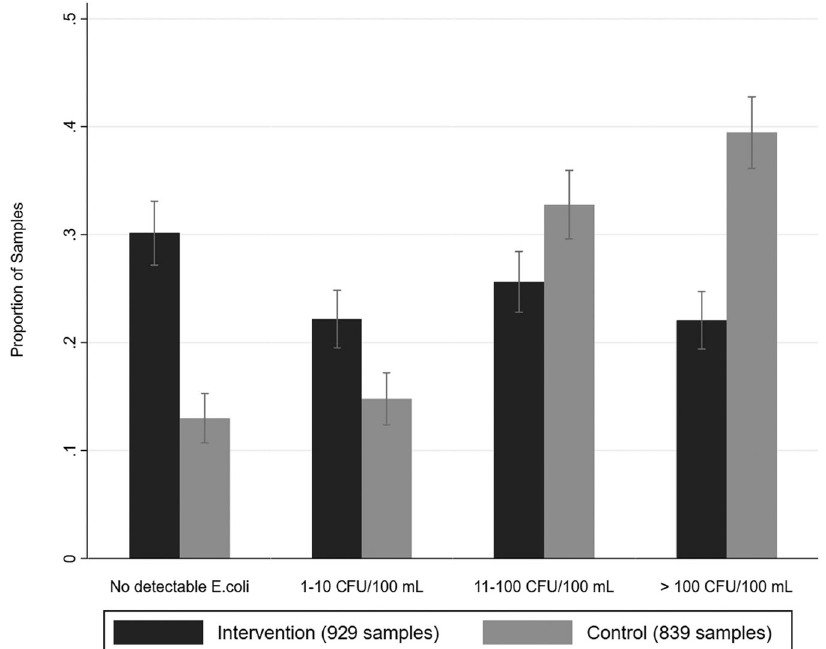
Fig. 2 Distribution of water quality result by WHO risk level (midline and endline combined). Bar graphs of the proportions of point-of-use water samples over the follow-up period that presented no detectable E. coli , 1 – 10 E. coli colony forming units (CFU), 11 – 100 E. coli CFU, or